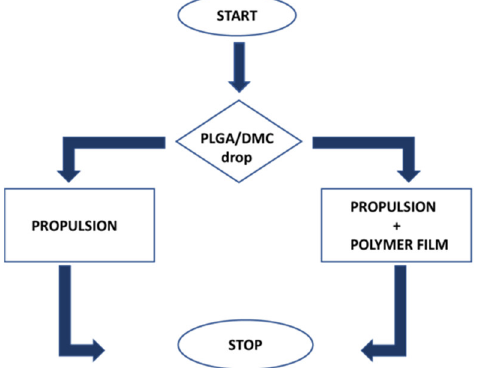
Figure 1. Flow chart of the process related to on-the-fly formation of polymeric thin films at water surface.